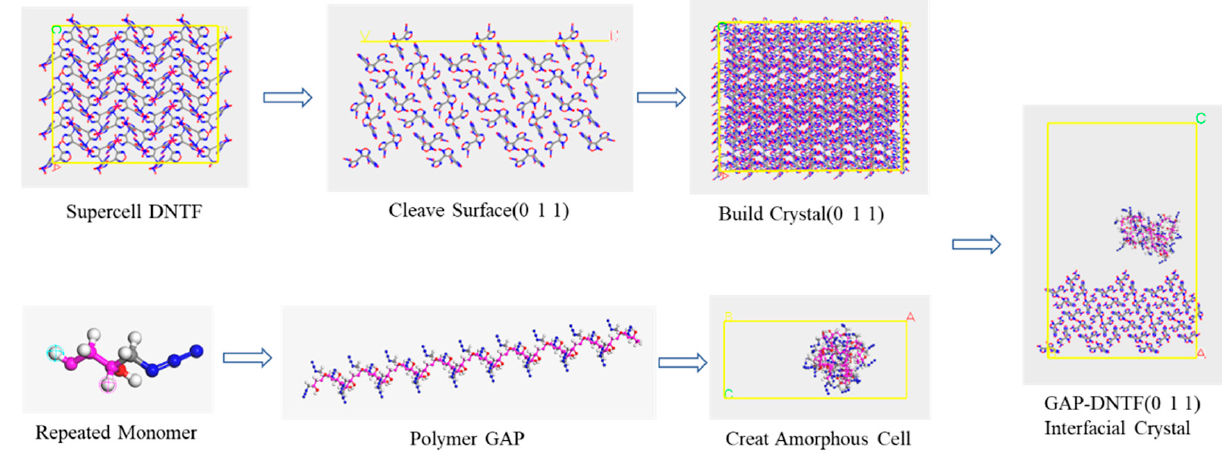
Figure 2. Establishing the interfacial crystal process.